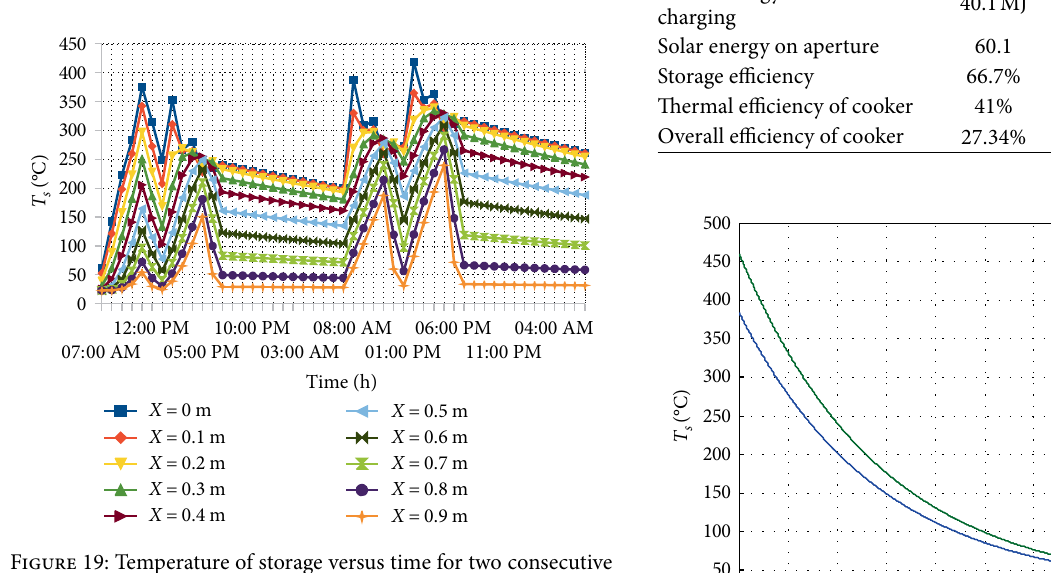
Figure 18: Temperature of storage versus temperature of water during boiling of 5 liters of water with 0.0048 kg/s mass flow rate for the lower direct normal irradiance.